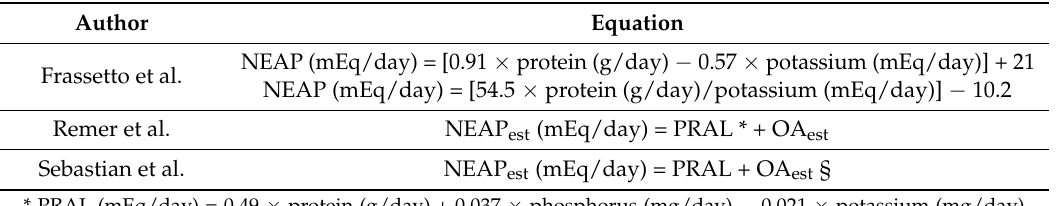
Table 1. Indirect estimation of NEAP, according to available equations